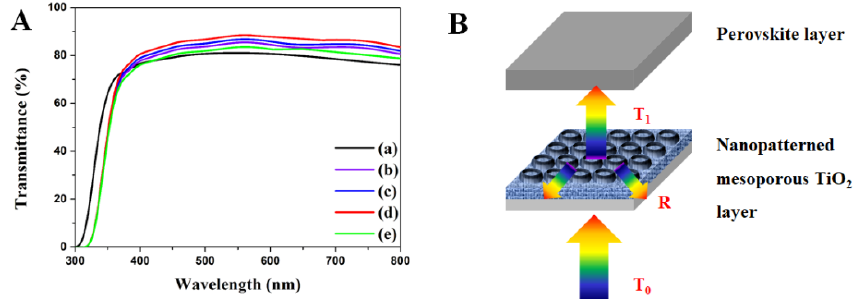
Figure 7. ( A ) Transmittance of nanopatterned mp-TiO 2 thin-film layer. ( B ) Schematic of the transmittance and reflectance of nanopatterned mp-TiO 2 thin-film layer. ( a ) Non-nanopatterned mp-TiO 2 thin-film layer. mp-TiO 2 thin-film layer nanopatterned at the depths of ( b ) 75 nm, ( c ) 97 nm, ( d ) 127 nm, and ( e ) 167 nm.